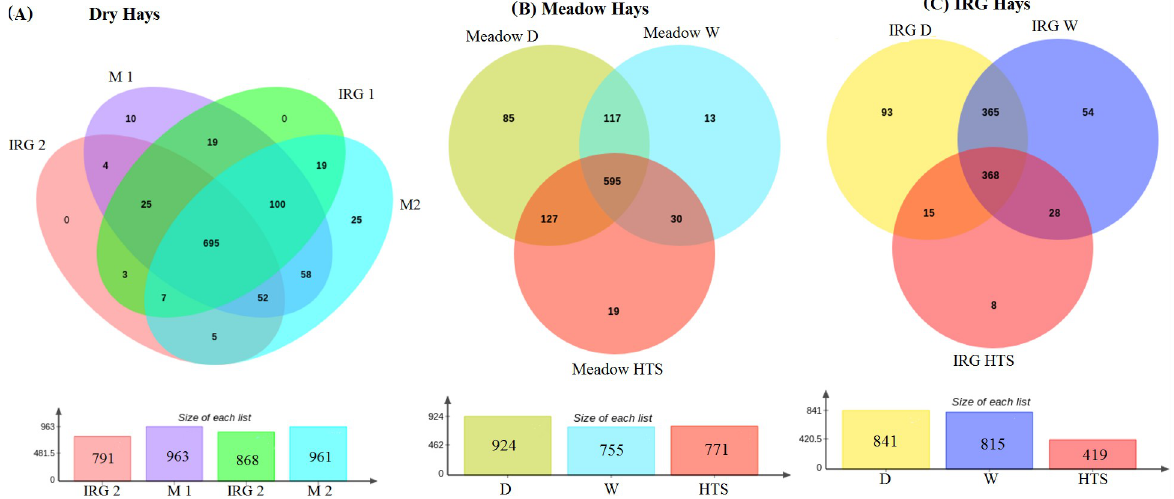
Fig 8. Core community for hay type, location and regimens. (A) Individual dry hays (M1 n = 3, M2 n = 3, IRG 1 n = 1, IRG2 n = 3), (B) Meadow hays following the regimens (D n = 6, HTS n = 6, W n = 6) and (C) IRG hays following regimens (D n = 4, HTS n = 3, W n = 5).